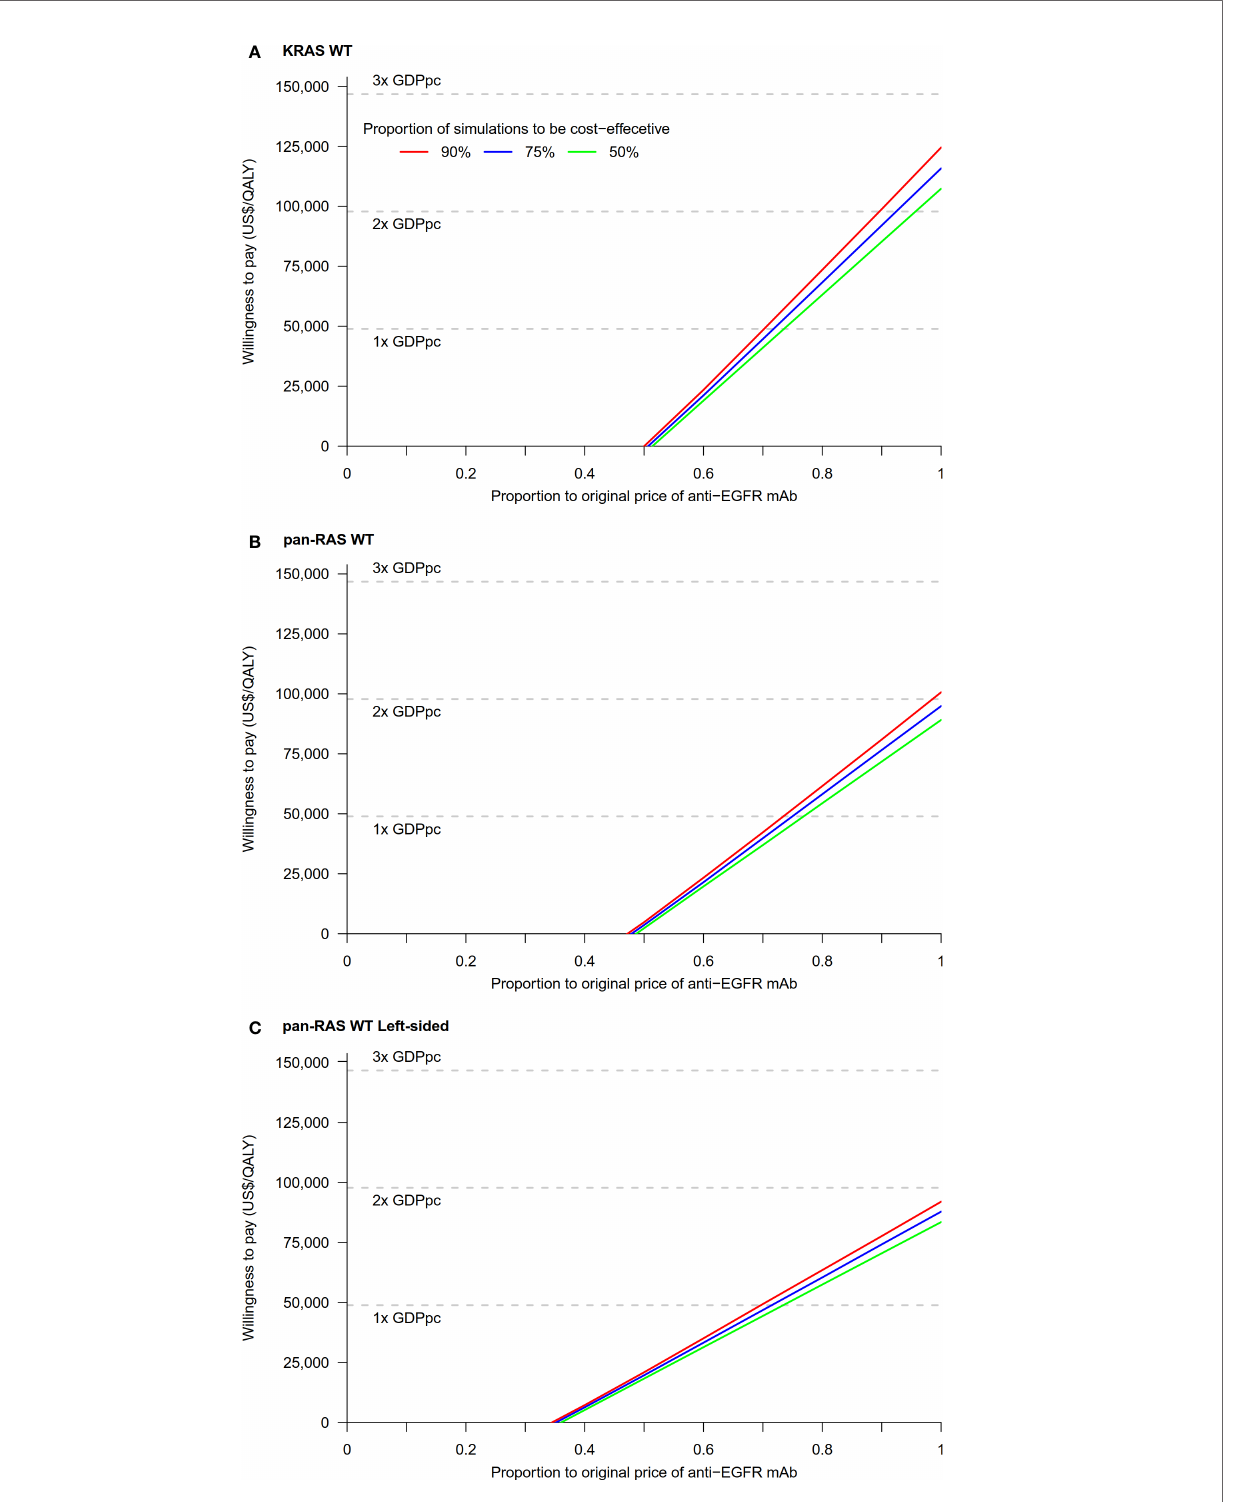
FIGURE 4 | Cost-threshold analyses: chemotherapy + anti-EGFR mAb vs. chemotherapy + bevacizumab in (A) KRAS WT, (B) pan-RAS WT, and (C) pan-RAS WT left-sided colonic tumor. anti-EGFR mAb, anti-epidermal growth factor receptor monoclonal antibody; GDPpc, gross domestic product per capita; QALY, quality- adjusted life year; WT,